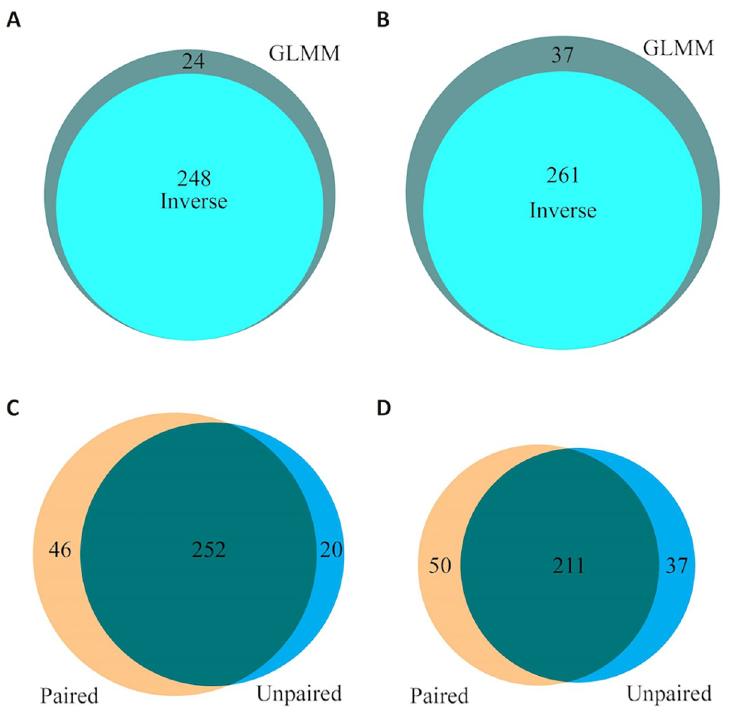
Fig 5. Consistency and comparison of pathways identified by GLMM and inverse variance in the paired and the unpaired analyses. A) Consistency between GLMM and inverse variance in the paired analysis. B) Consistency between GLMM and inverse variance in the unpaired analysis. C) Comparison between the paired and unpaired analyses by the GLMM method. D) Comparison between the paired and unpaired analyses by the inverse variance